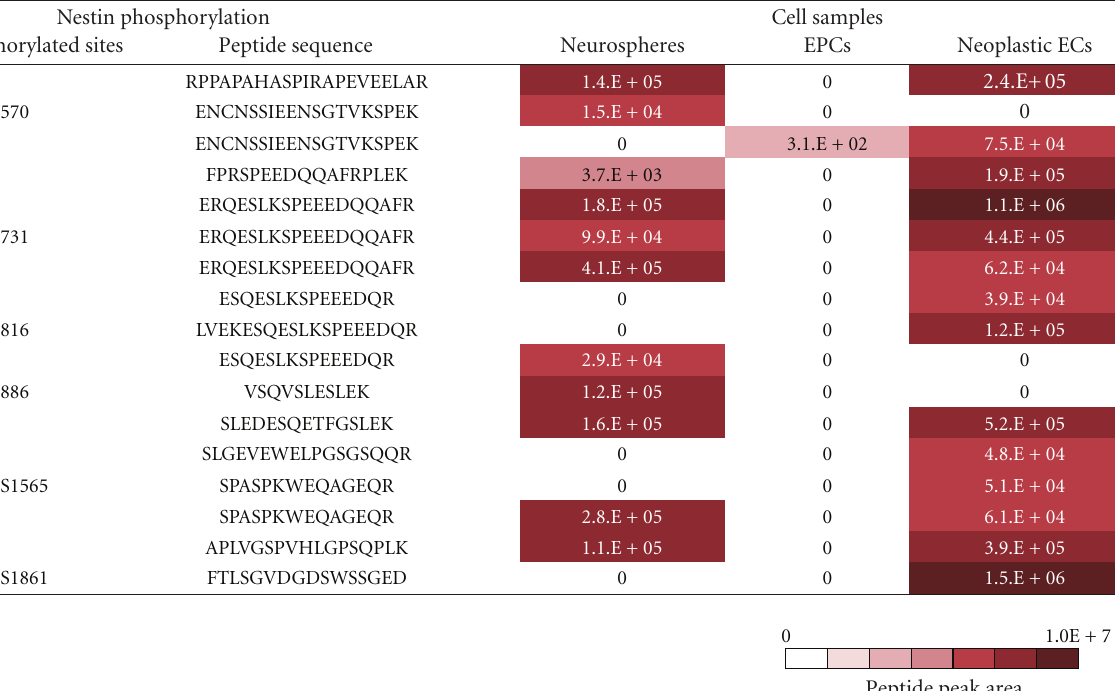
Figure 1: Quantitative phosphoproteome analysis of Nestin. A peak area of more than 1 . E+04 indicates significant phosphorylation detected by MS/MS. pSites, phosphorylated sites of amino acid